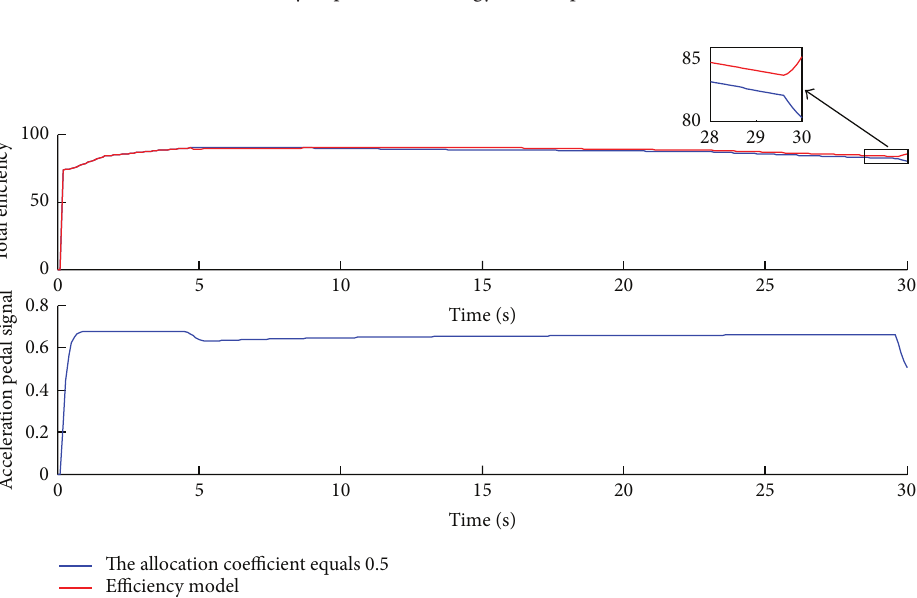
Figure 17: The time history of power and energy consumption over the acceleration DC.